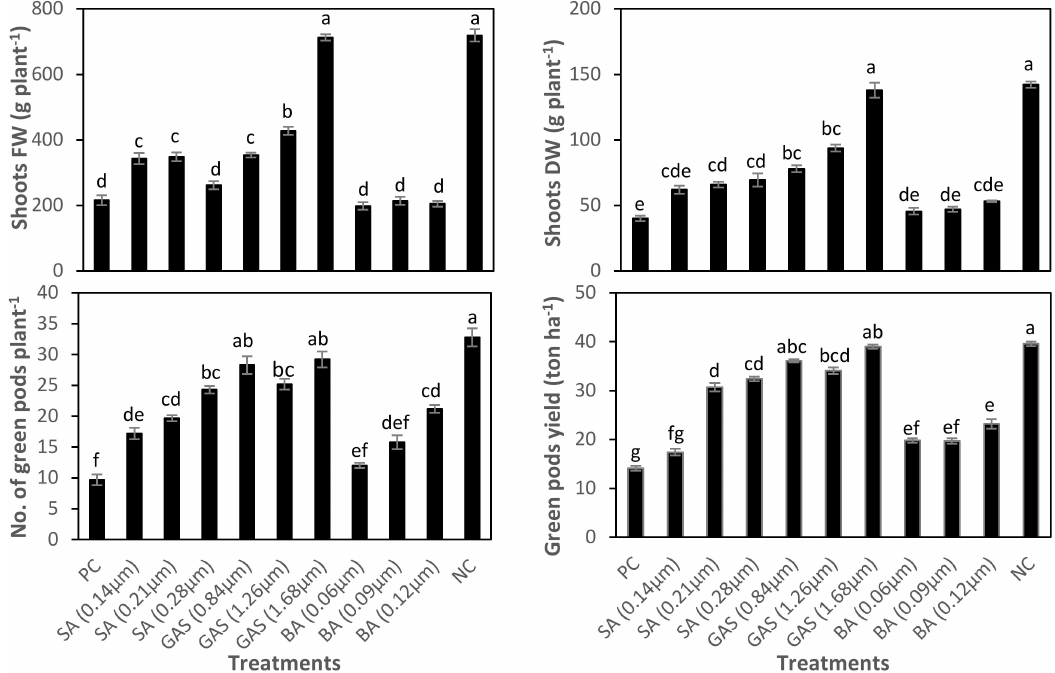
Figure 9. Variation in shoots fresh (FW) and dry weight (DW), number of pods, and green pods yield in negative control plants (NC), positive control plants (PC), and in response to foliage appli- cation of nano-salicylic acid (SA; 0.14, 0.21, and 0.28 µ M), nano-glycyrrhizic acid ammonium salt (GAS; 0.84, 1.26, and 1.68 µ M), and nano-boric acid (BA; 0.06, 0.09, and 0.12 µ M) to phytoplasma- infected faba bean plants. Means followed by the same letter in each column were not significantly different according to Duncan’s multiple range test ( p ≤